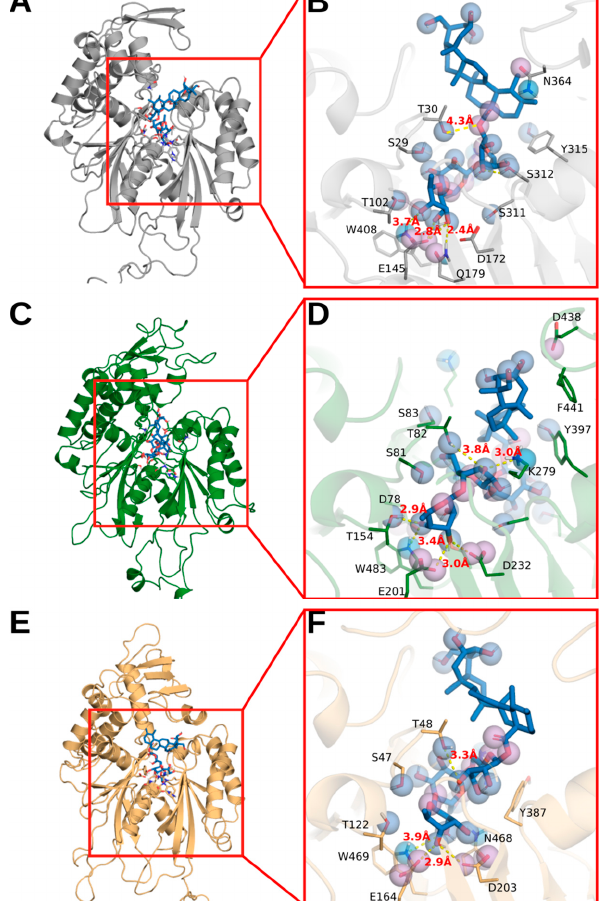
Figure 5. Molecular docking assays of asiaticoside and NTPDases. In ( A , C , E ) are represented the ECD domain of apyrase, SmNTPDase 1, and SmNTPDase 2, respectively. ( B , D , F ) show the best conformations of asiaticoside, using Autodock Vina, for apyrase, SmNTPDase 1, and SmNTPDase 2, respectively. Spheres represent pharmacophoric characteristics: hydrogen bond donor (light blue), hydrogen bond acceptor (purple), hydrogen bond donor and acceptor (blue).